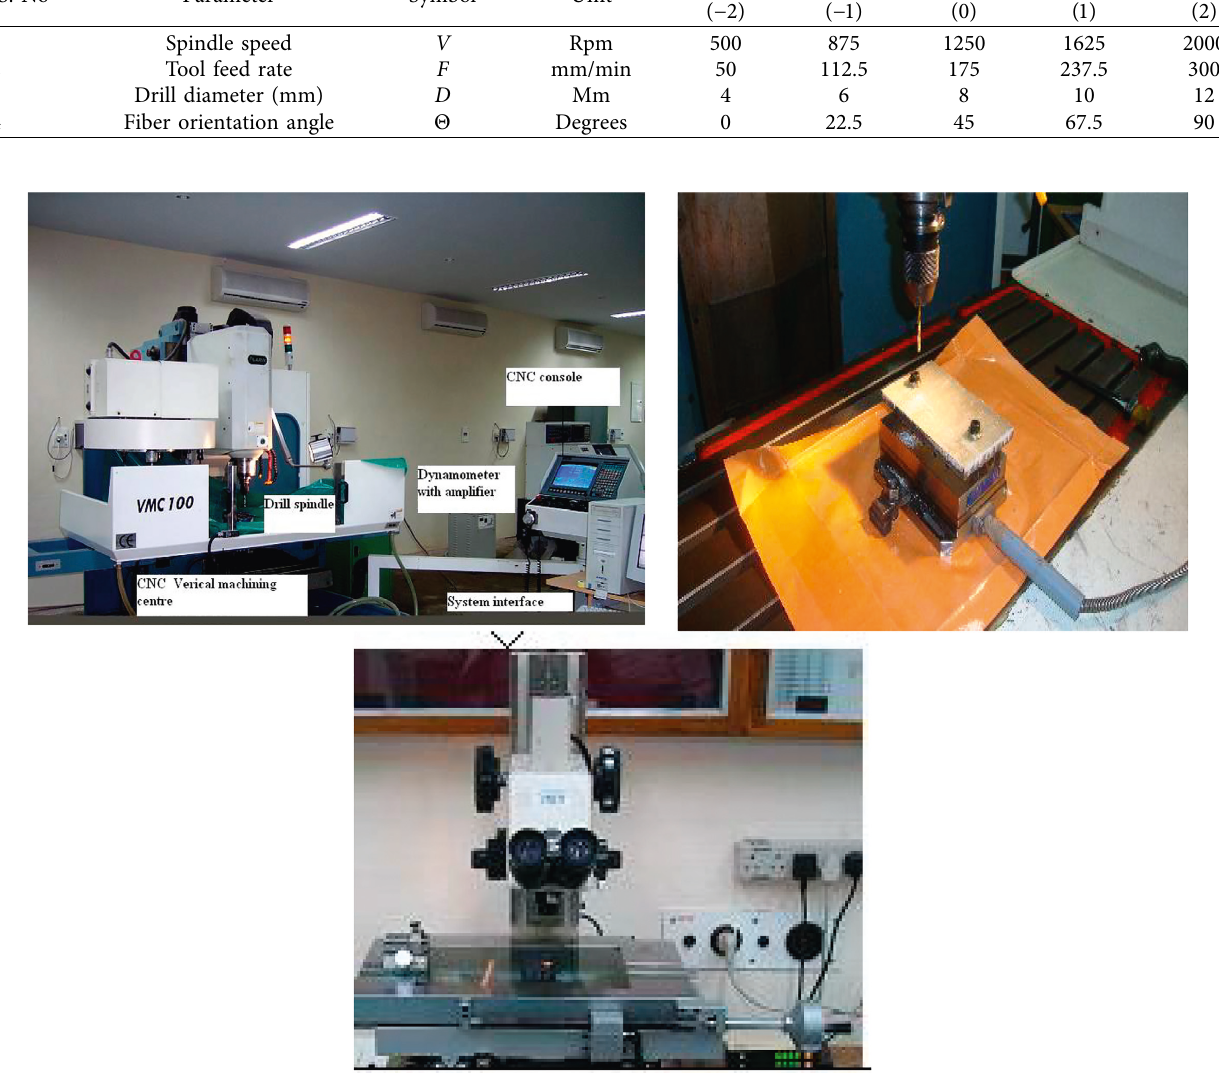
Figure 1: Machine used for